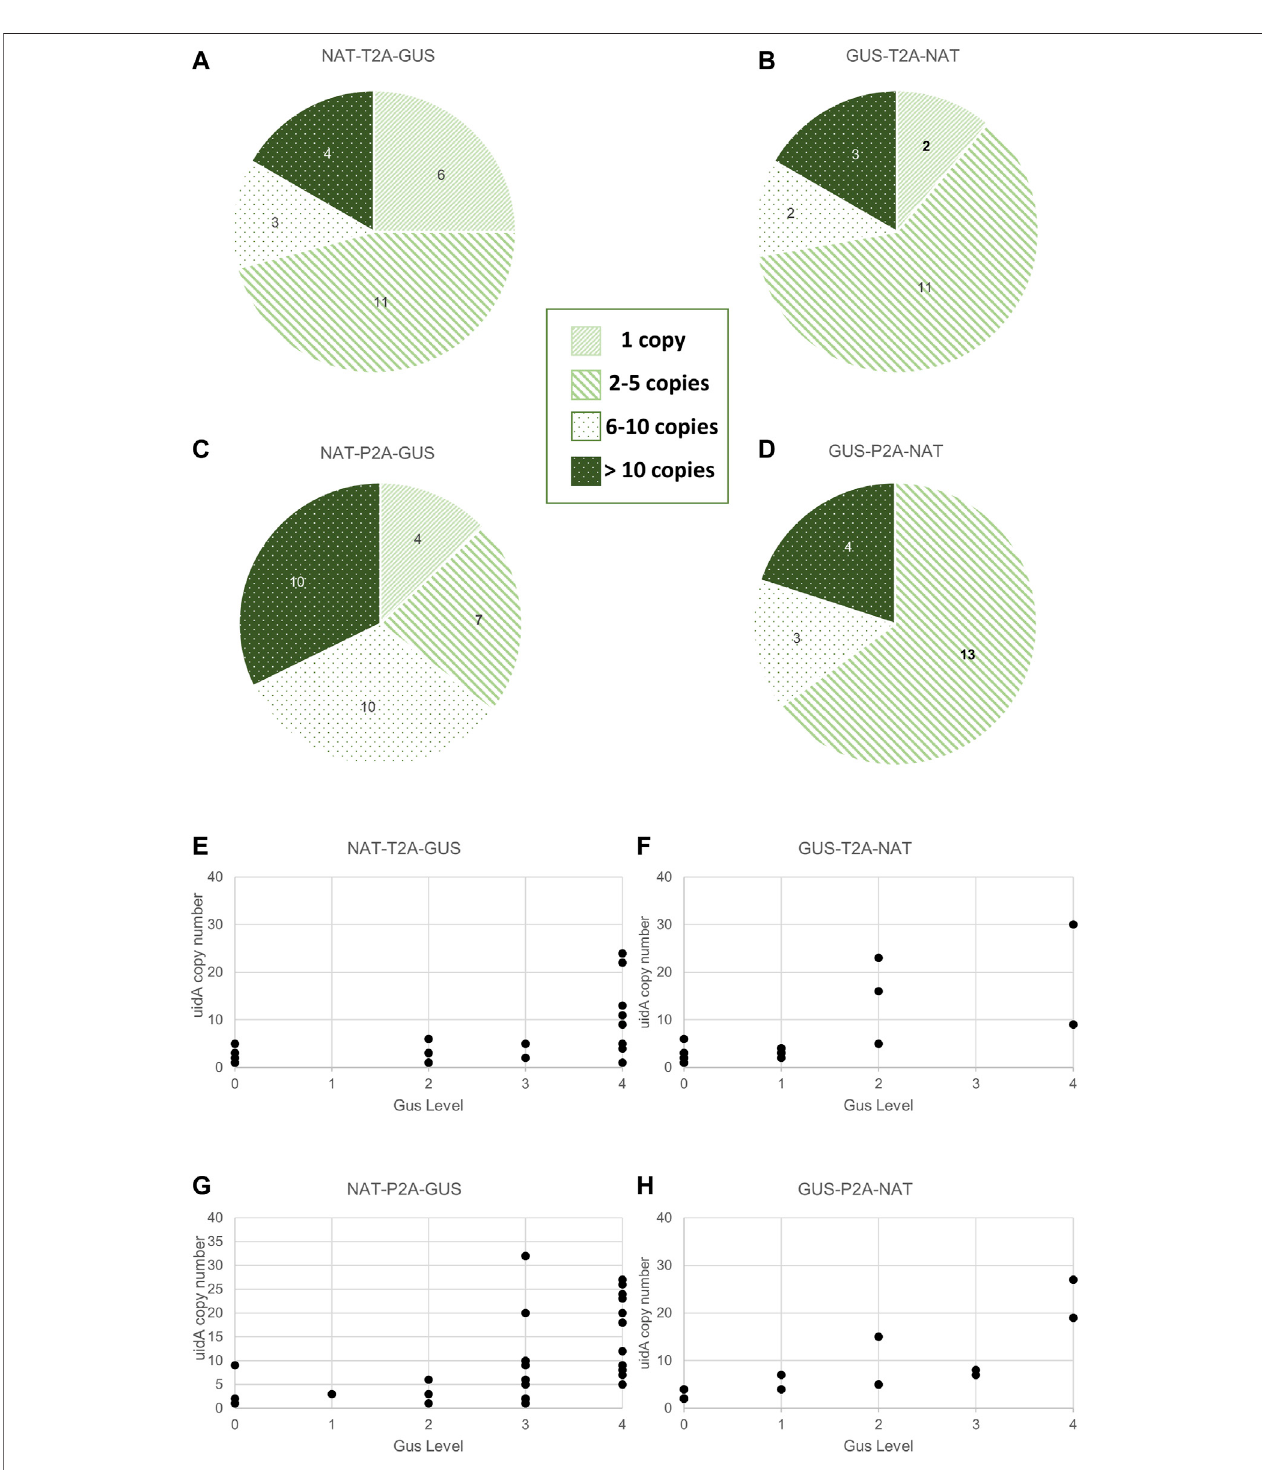
FIGURE 4 | Relationship between transgene copy number and GUS intensity in the various groups. (A – D) Distribution of uidA copy number in the various groups. Clones were classi fi ed according to the following fi ve categories: 0 copy, 1 copy, 2 to 5 copies, 6 to 10 copies, and over 10 copies. Values indicated in the pie chart are the number of clones assigned to the category. A statistical analysis was performed on the groups and revealed no difference between all groups except for NTG and NPG (Wilcoxon test, p -value (cid:2) 0.02). (E – H) Distribution of uidA copy number according to the color intensity in the various groups. The uidA copy number ( y -axis) determined via ddPCR and the GUS intensity level associated ( x -axis) for each clone of the four working groups are shown.